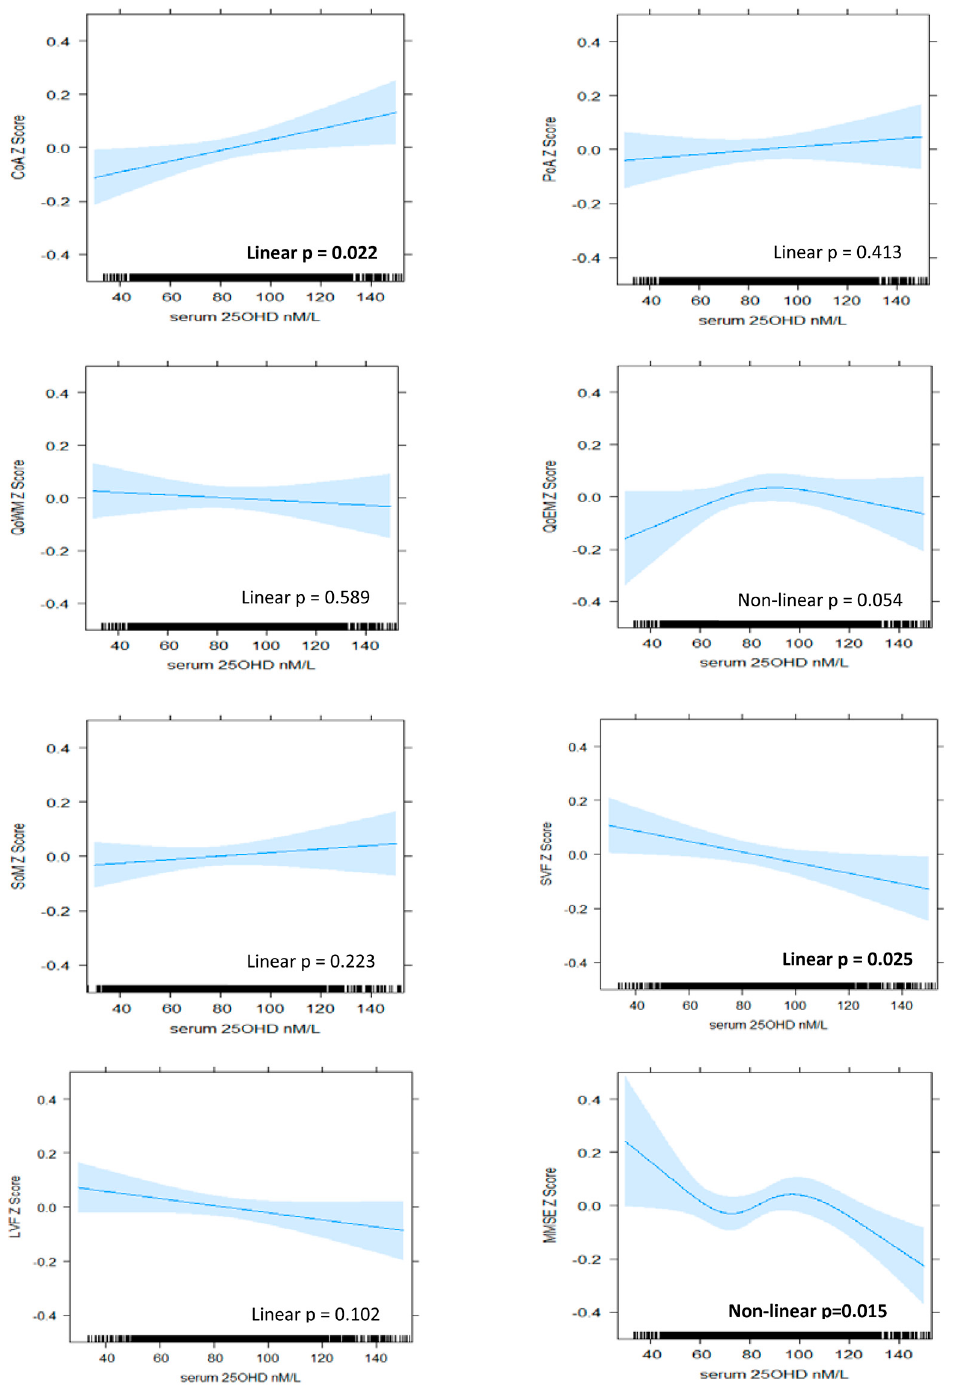
Figure 2. The association between serum 25OHD level (nM/L) and cognitive z -scores in BHAS men. Plots derived from ‘best fit’ of nonlinear (RCS) versus linear and fully adjusted models (Model 4). Model 4 includes de-seasonalised serum 25OHD level, age, estimated IQ, BMI, alcohol consumption, smoking status, physical activity, sitting hours per day, employment status, self-reported use of vitamin D supplements, self-reported health status, individual histories of hypertension, cardiovascular disease, diabetes, depression, and anxiety. CoA, continuity of attention; PoA, power of attention; QoWM, quality of working memory; QoEM, quality of episodic memory; SoM, speed of memory; SVF, semantic verbal fluency; LVF, letter verbal fluency; MMSE, Mini-Mental State